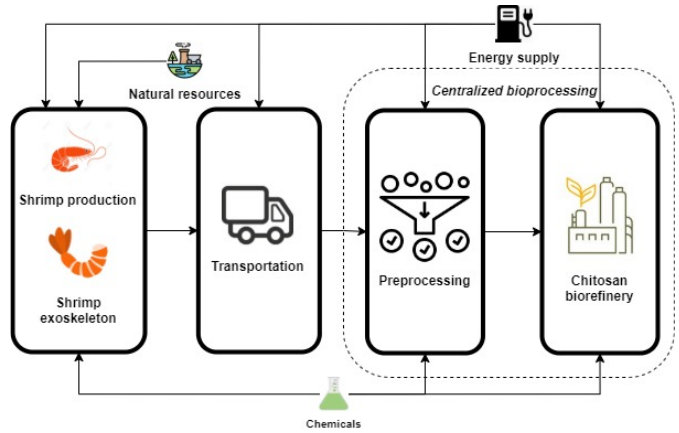
Figure 4. Cradle to gate boundary for chitosan production.